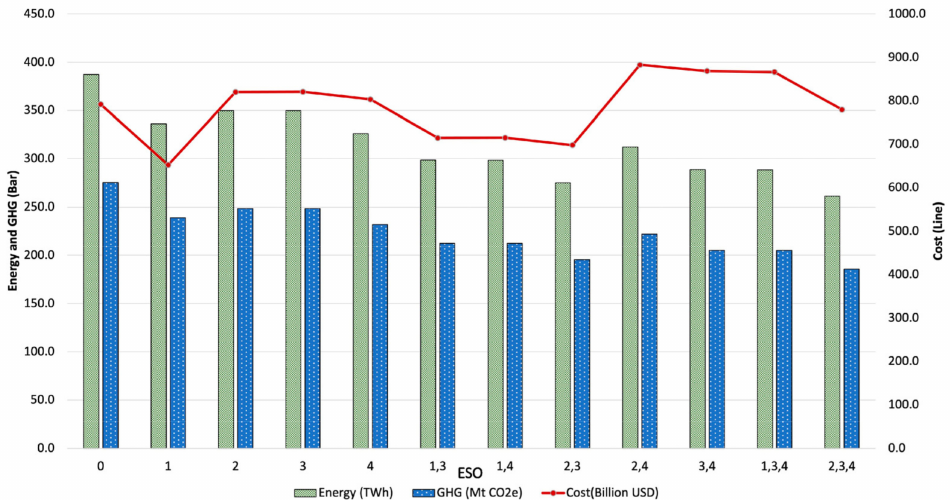
Figure 9. Total energy consumption, GHG emissions, and cost in the residential sector in Saudi Arabia in